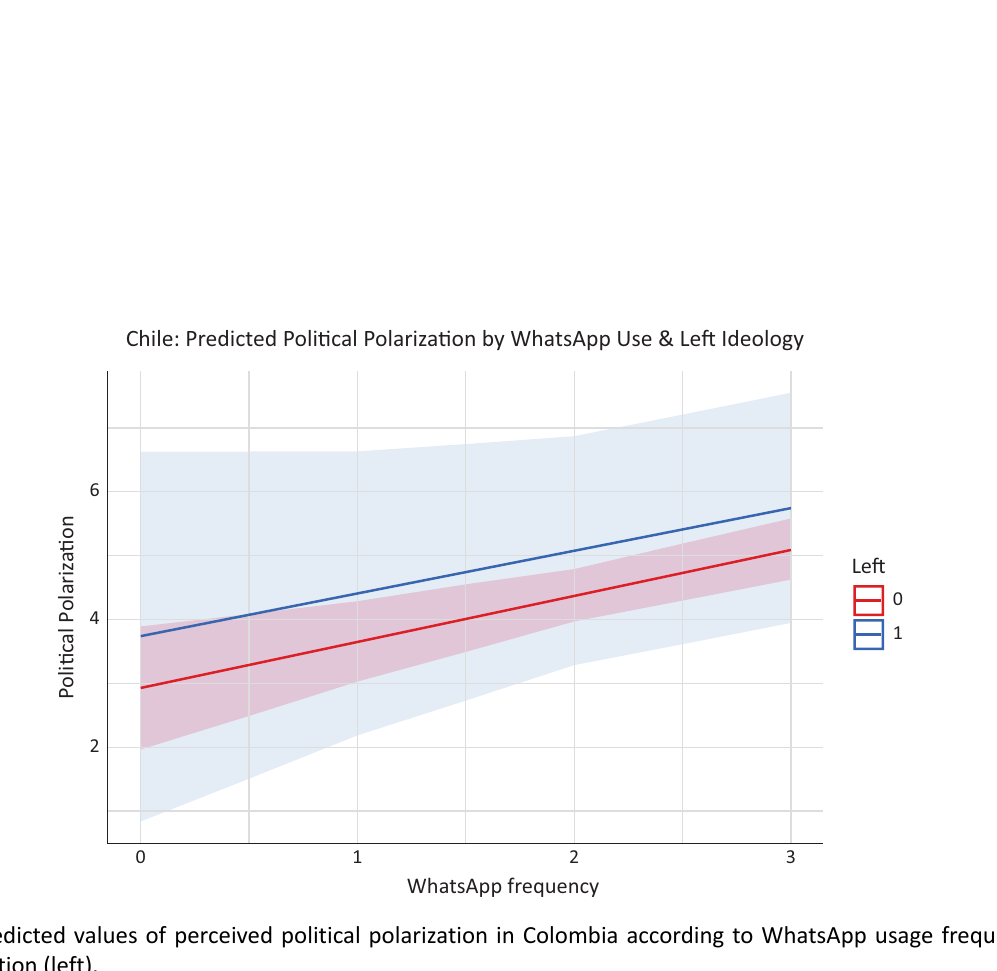
Figure 2. Predicted values of perceived political polarization according to WhatsApp usage frequency.